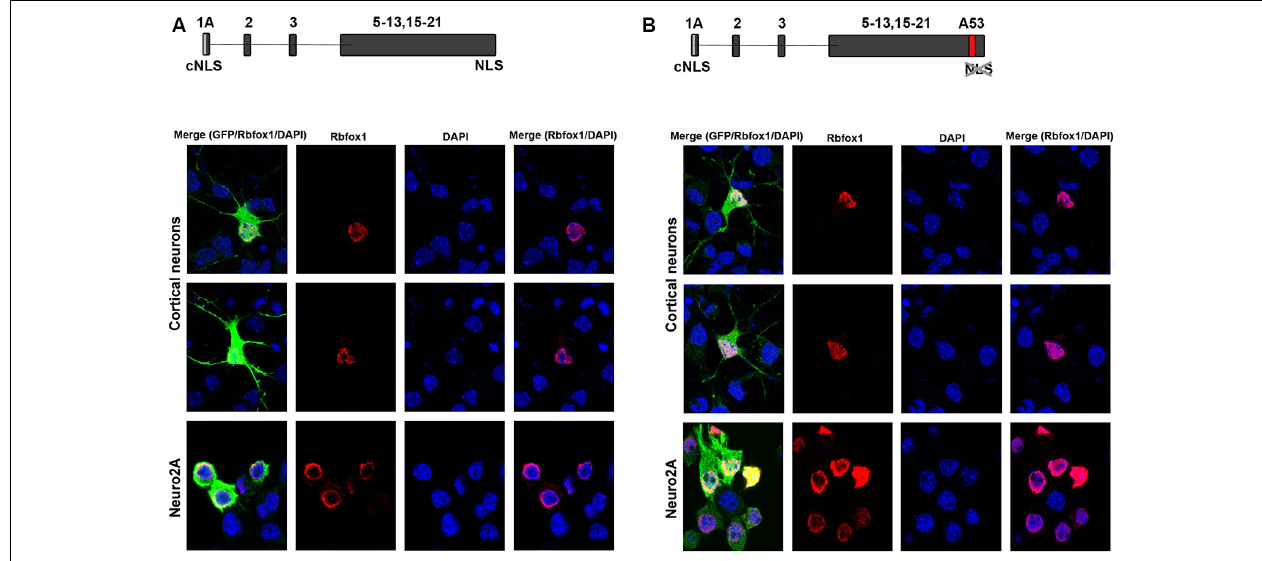
FIGURE 2 | Expression of novel Rbfox1 isoforms starting from exon 1A in N2A cells and primary neurons. (A,B) Immunofluorescence analysis of the subcellular localization of the two Rbfox1 isoforms starting from exon 1A. N2A cells or primary cortical neurons were transfected with constructs encoding the untagged Rbfox1 isoforms followed by an IRES GFP. Twenty-four hours later cell were fixed and immunofluorescence stainings were performed with antibodies specific for Rbfox1 and GFP. (A) Construct encoding Rbfox1 isoform starting from exon 1A and lacking exon A53. (B) Construct encoding Rbfox1 isoform starting from exon 1A and containing exon